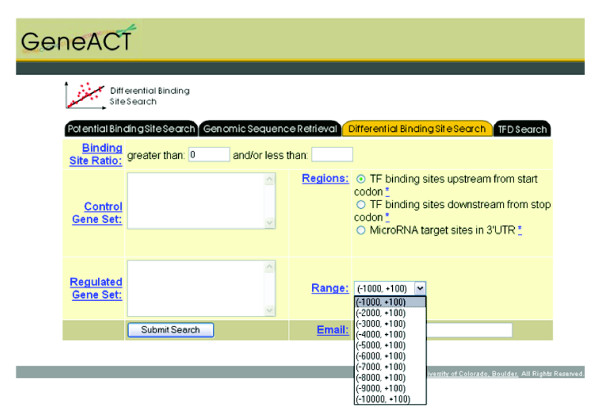
Web interface of the differential binding site search. Gene IDs from control gene set (unchanged in DNA microarray data) and regulated gene set (upregulated or downregulated from microarray data) are pasted into respective windows. The threshold of binding site ratio is defined by the user. The user can specify a range of interest with three choices of regions (upstream from the transcription start site, upstream from the start codon, or downstream from the stop codon). TF, transcription factor.